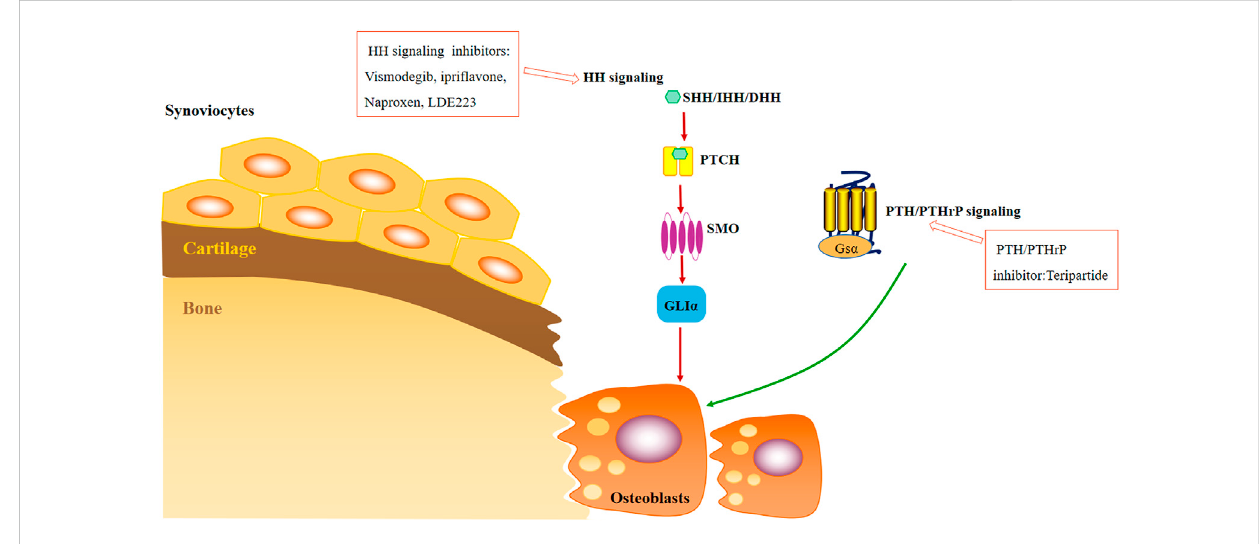
FIGURE 4 Small molecular therapeutic agents focused on inhibiting